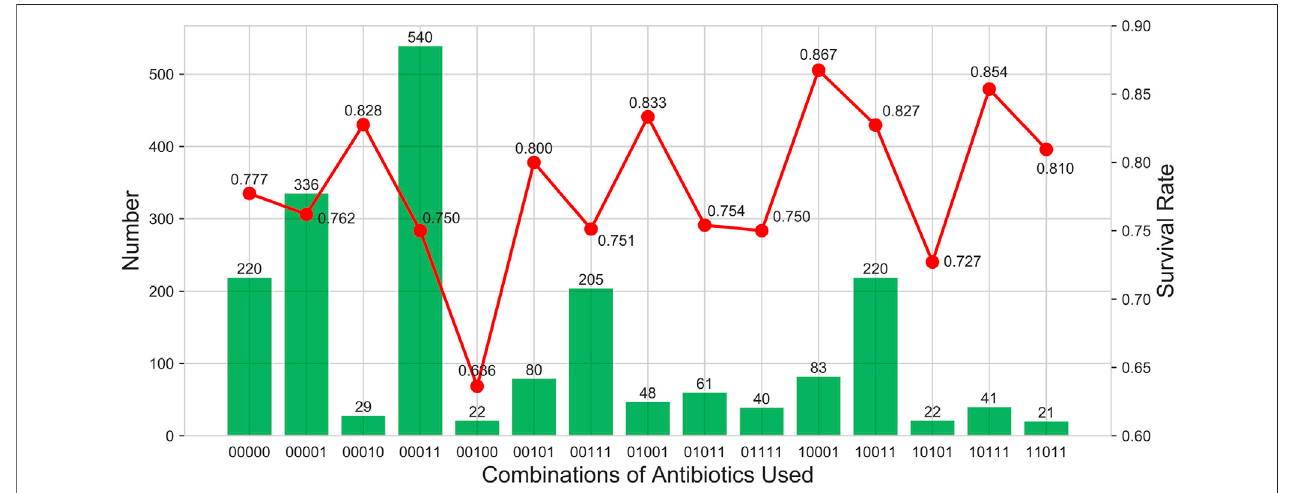
FIGURE 4 | Describe the use of antibiotics, the number of people and survival rates. The columns show the number of people who took drugs. The broken line shows thesurvivalrate.The horizontal coordinate isa5-digit sequence from lefttoright representing the fi rsttofourth generationsofcephalosporins and vancomycin.0 indicates that it is not used, and one indicates that it is used.